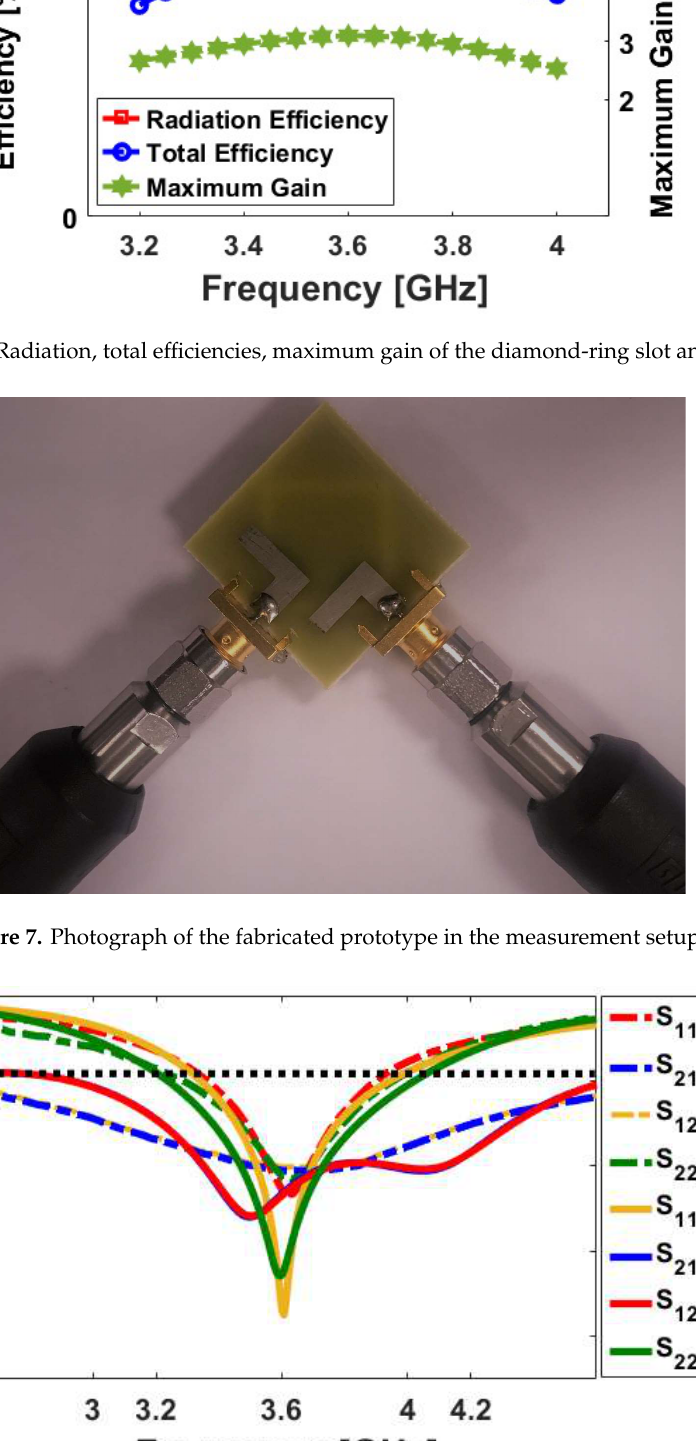
Figure 8. Measured and simulated S parameter results of the fabricated antenna.